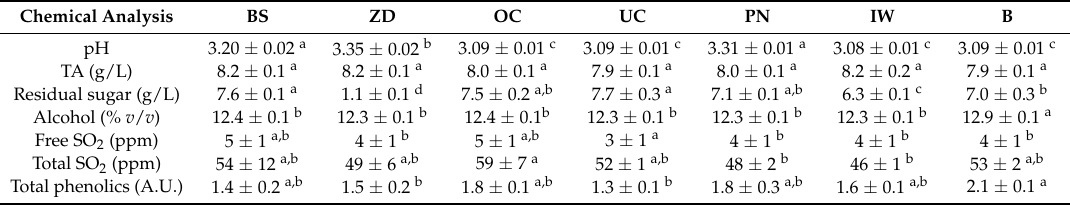
Table 4. Chemical analyses of treatment wines 15 weeks after disgorging with dosage